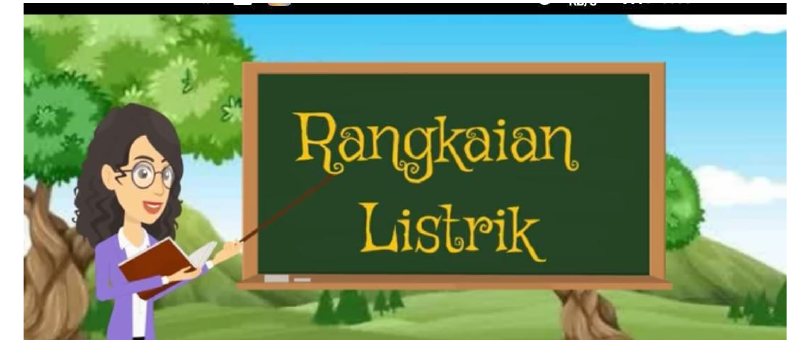
Figure 4 : Learning video with electrical circuit